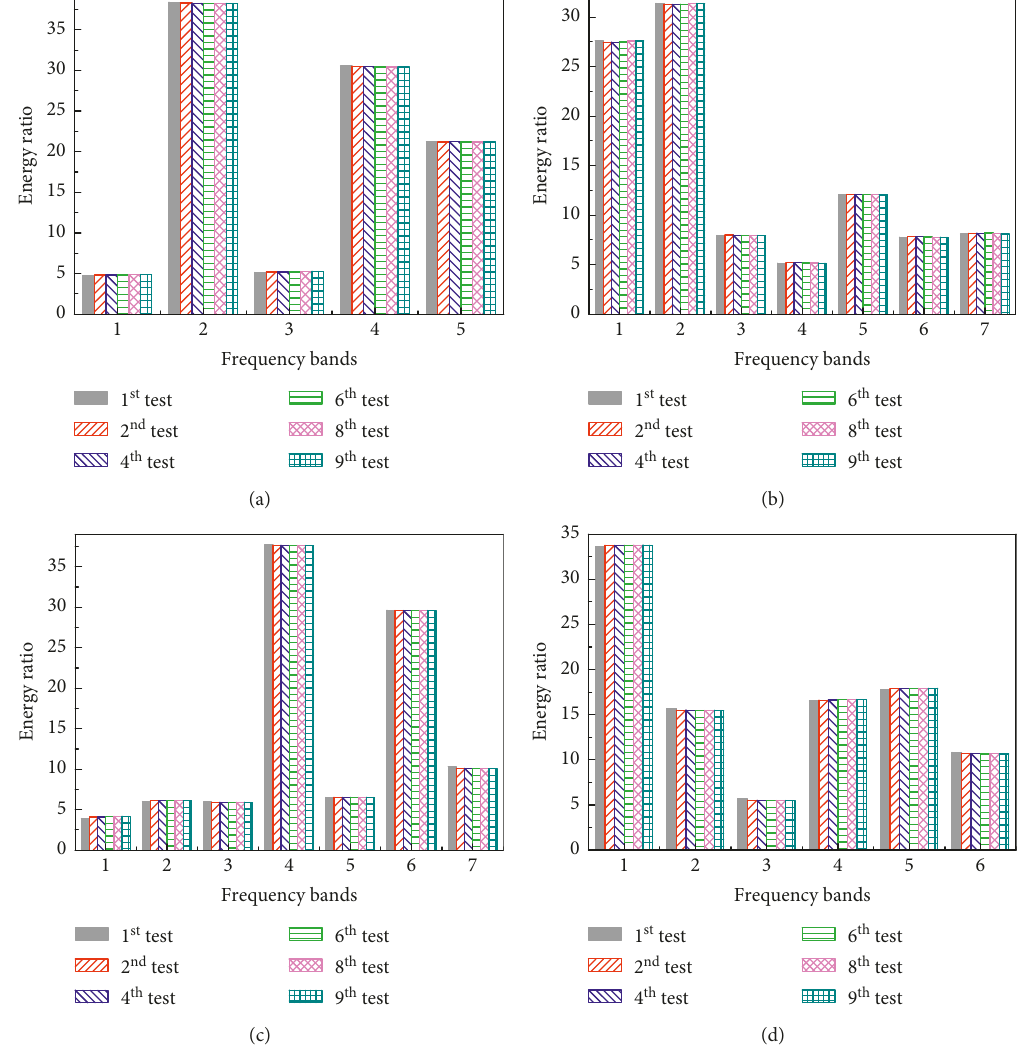
Figure 22: Hilbert feature vector spectrum in field tests. (a) Point 1. (b) Point 2. (c) Point 5. (d) Point 7.